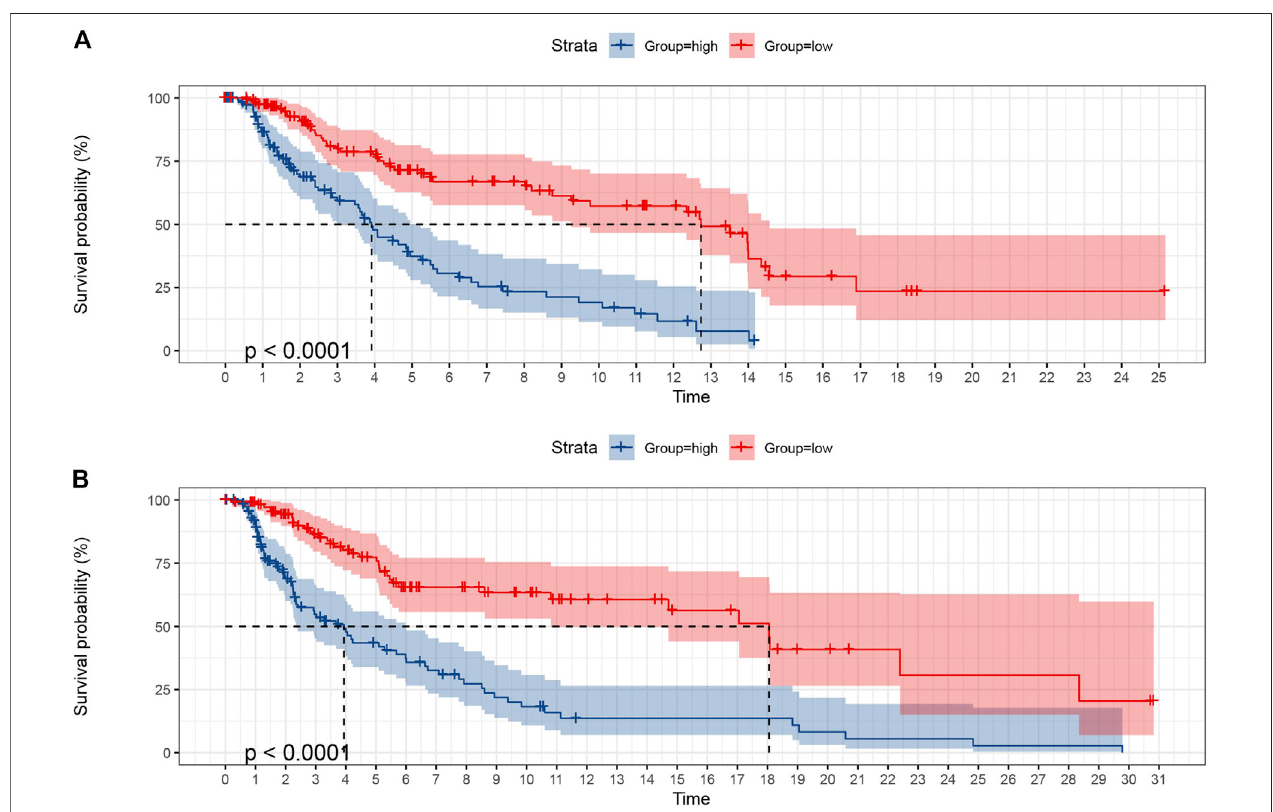
FIGURE8| TheK-McurvesofOSshowedthefavorablepredictivevalueoftheprognosticmodelinthetrainingset (A) andvalidationset (B) asSKCMpatientswere randomly divided from the middle.